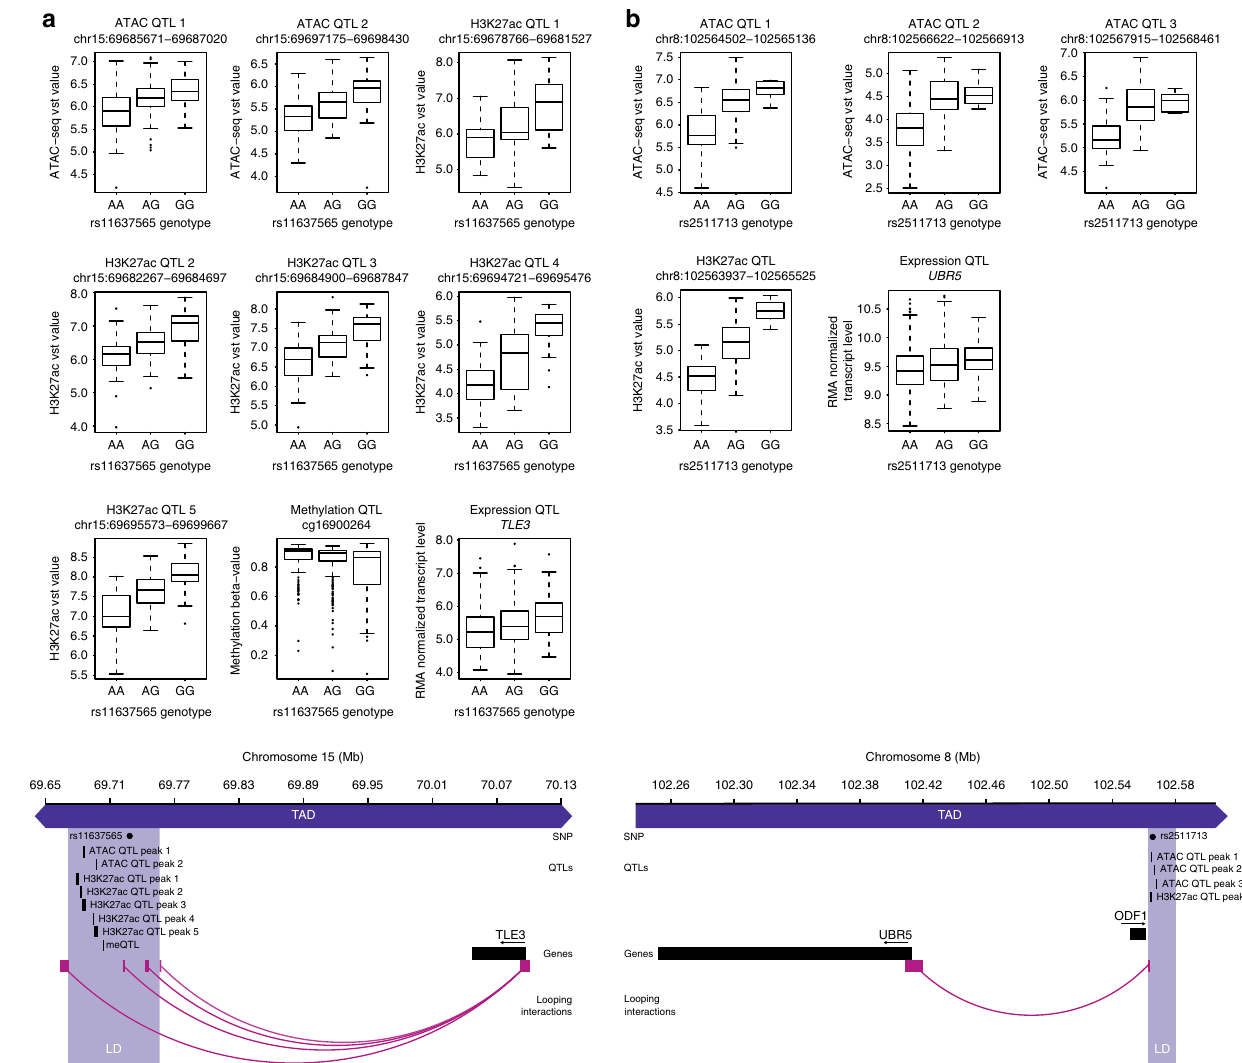
Fig. 4 Characterization of quantitative trait loci (QTLs) and looping interactions at the 15q23 and 8q22.3 chronic lymphocytic leukemia (CLL) risk loci. (Top panels) Boxplots illustrating associations between a rs11637565 and b rs2511713 genotypes and chromatin accessibility (assay for transposase-accessible chromatin(ATAC) QTL), histone H3 lysine 27 acetylation (H3K27ac QTL), DNA methylation (methylation QTL), and candidate target gene transcript levels (expression QTL) in CLL patients (number of independent CLL samples for ATAC: n = 99, H3K27ac: n = 97, DNA methylation: n = 486, and transcript levels: n = 452). (Lower panels) Chromosomal positions of sentinel single-nucleotide polymorphisms (SNPs; rs11637565/rs2511713, gray dots), QTL peaks/probes, and coding genes (black rectangles). The linkage disequilibrium (LD) regions, encompassing SNPs in LD r 2 ≥ 0.2 with the sentinel SNPs are indicated by light blue rectangles. Also shown are looping interactions (pink arcs) from the LD regions to the promoters of TLE3 and UBR5. Pink rectangles represent interacting HindIII fragments. Topologically associating domains (dark blue rectangles, TAD) containing all features are truncated for clarity; their extension beyond the fi gure boundaries is indicated by